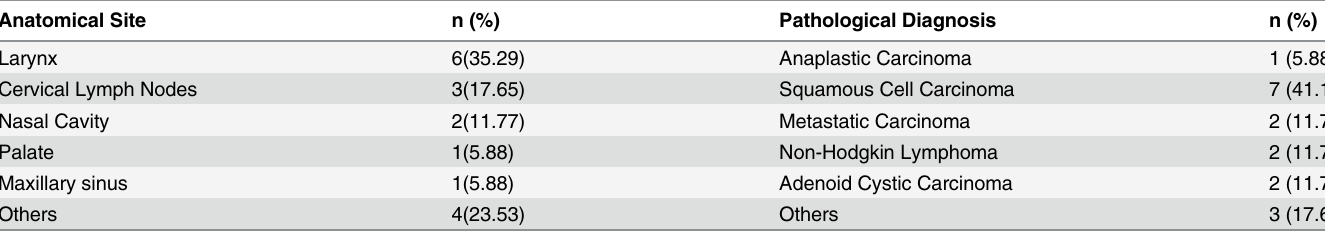
Table 4. Distribution by Anatomical Site and Pathological Diagnosis of Final Sample (n =